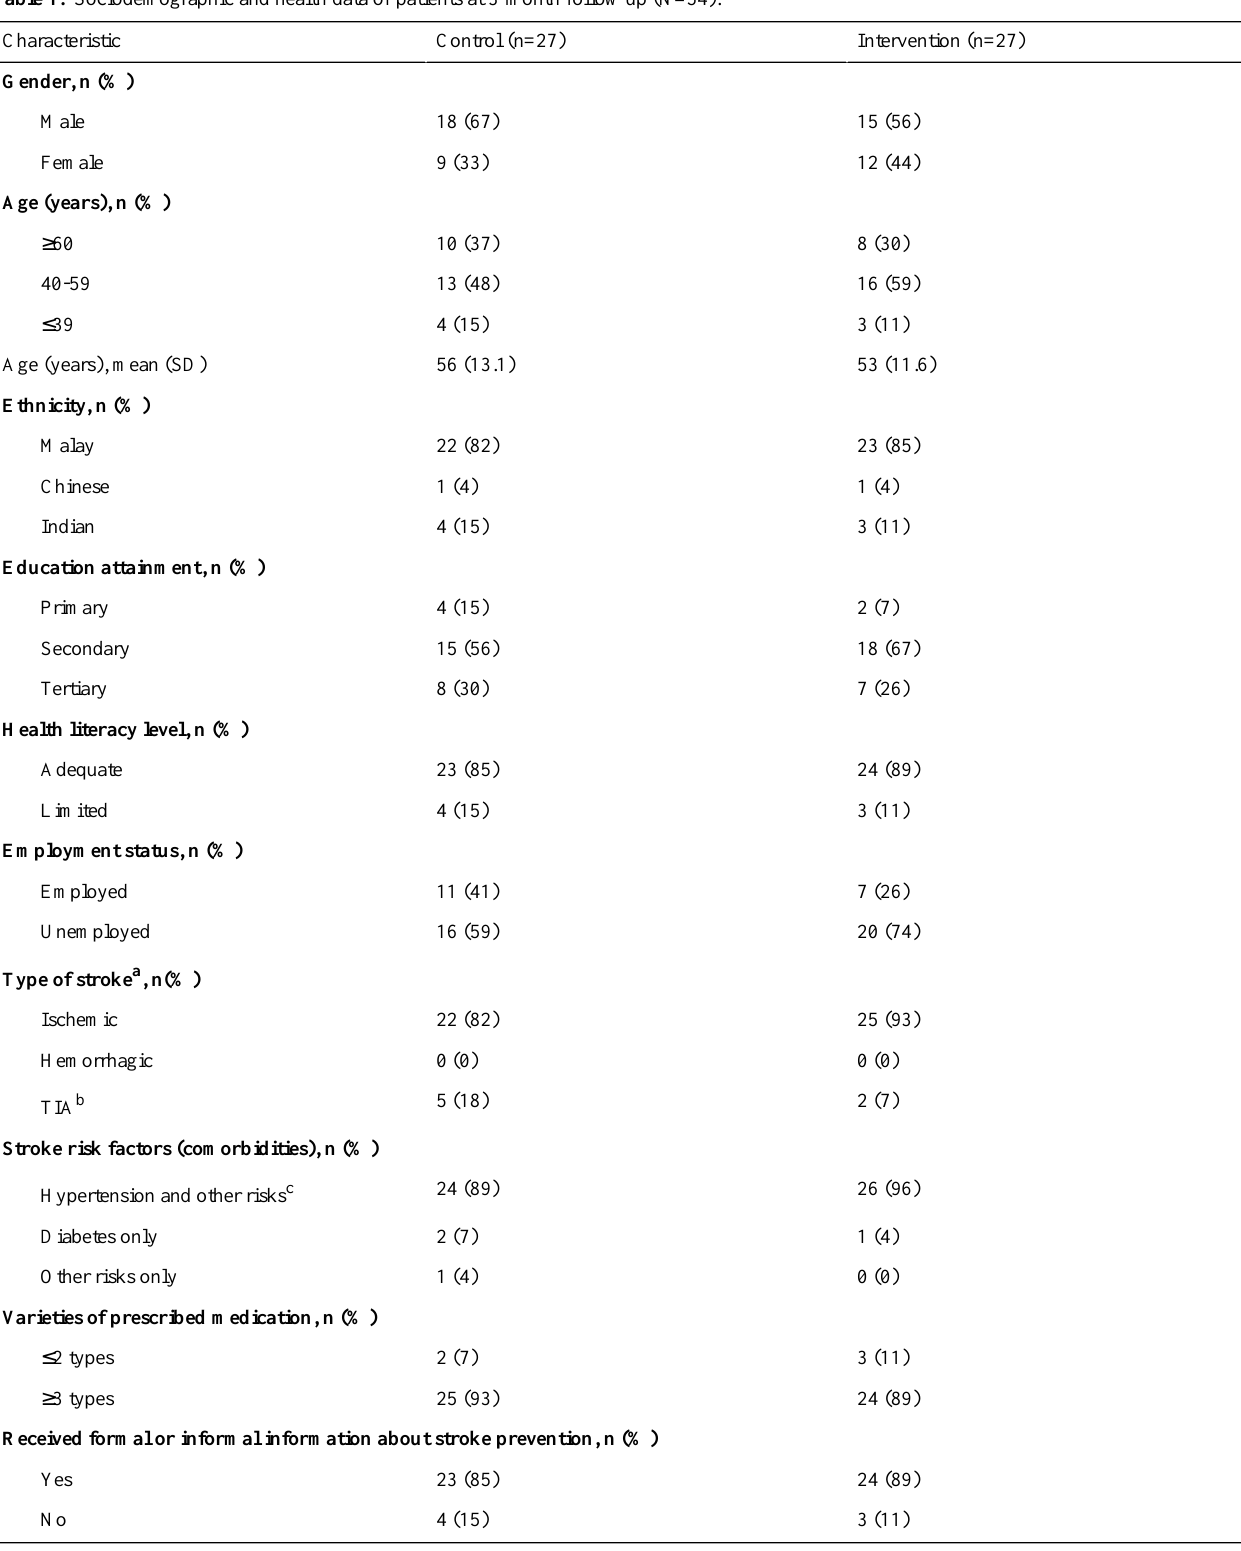
Table 1. Sociodemographic and health data of patients at 3-month follow up